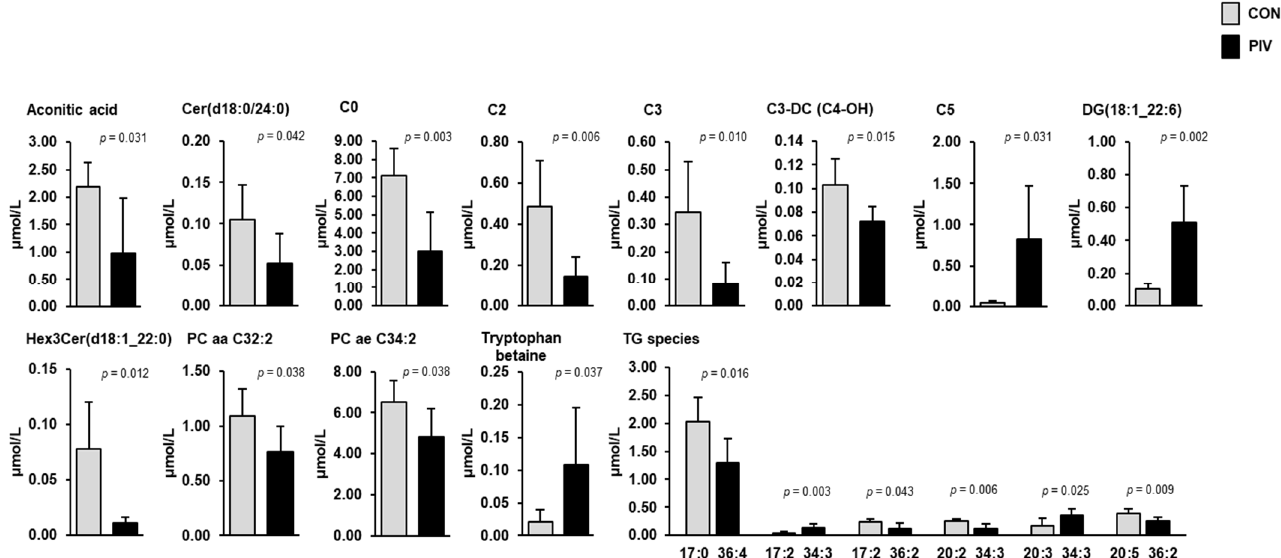
Figure 3. Concentrations of plasma metabolites regulated between 5-week-old pigs orally administered either vehicle (group CON) or pivalate (group PIV) for 28 days as identified by targeted plasma metabolomics. Bars are means ± SD for n = 6 pigs/group. Abbreviations: aa, acyl-acyl residue; ae, acyl-alkyl residue; C, carnitine; C0, free carnitine; C2, acetylcarnitine; C3, propionylcarnitine; C3-DC (C4-OH), malonylcarnitine (3-hydroxybutyrylcarnitine); C5, isovalerylcarnitine, valerylcar- nitine, 2-methylbutyrylcarnitine and/or pivaloylcarnitine; DG, diacylglycerol; Cer, ceramide; PC, phosphatidylcholine; Hex3Cer, trihexosylceramide; TG, triacylglycerol species (with number of C-atoms and double bonds of one fatty acid and the sum of the number of C-atoms and double bonds of the other two fatty